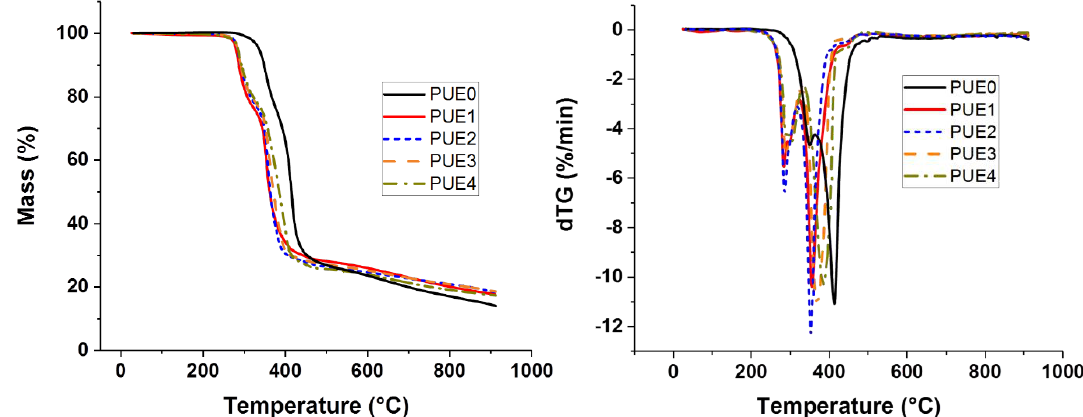
Figure 7. TG and derivates of thermogravimetric curve (DTG) for PUE/APP/S9 composites.